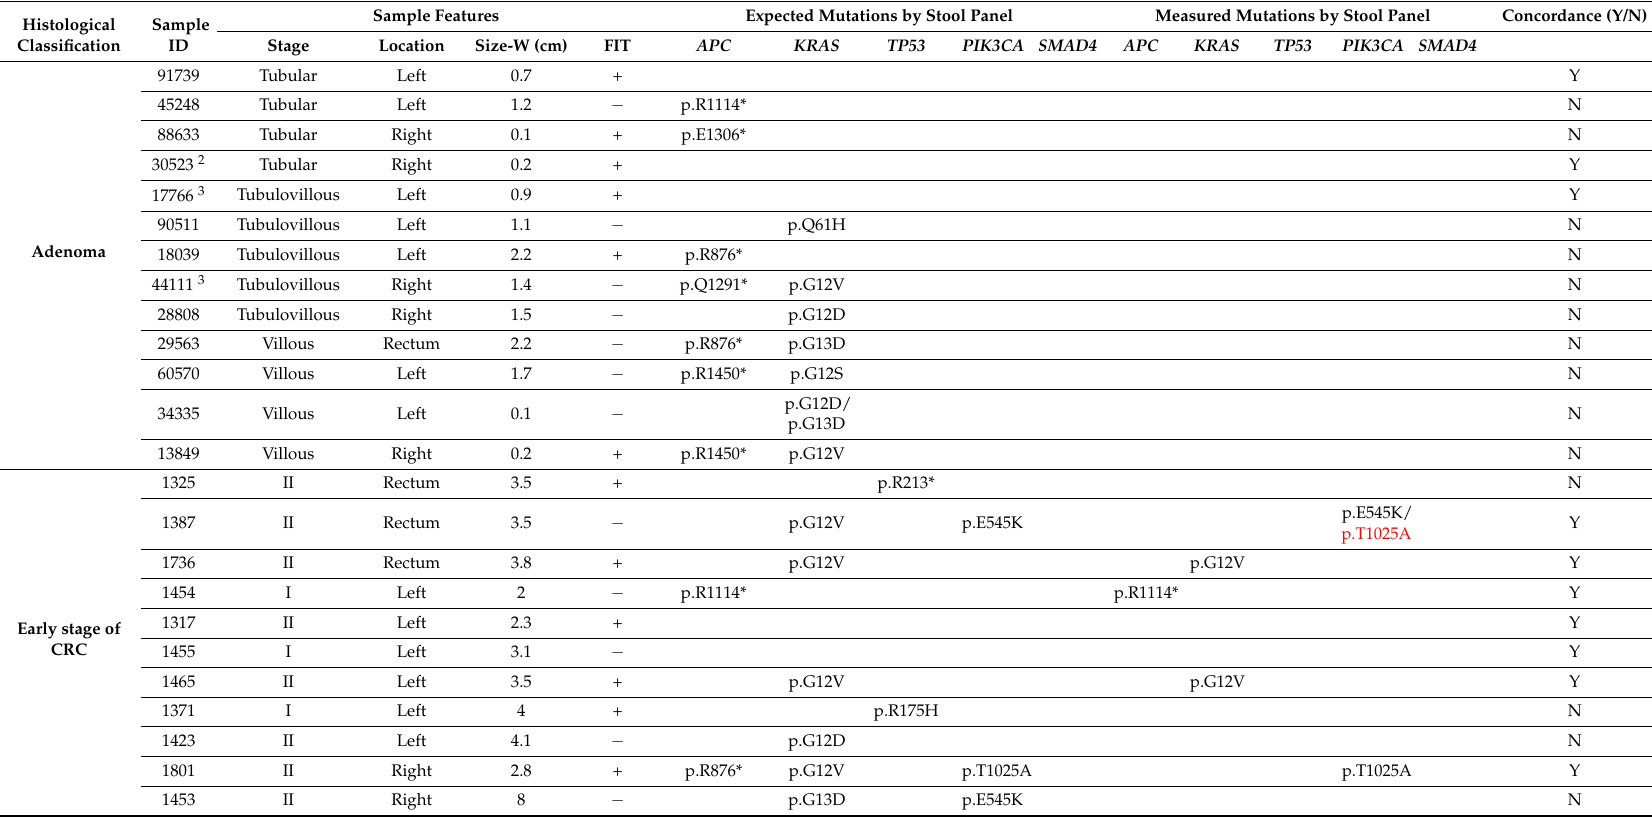
Table 3. Histological characteristics and mutations in paired tissue and stool samples from 13 polyps and 21 CRC